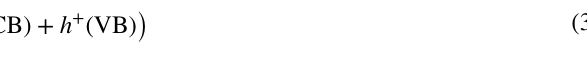
Fig. 12 Possible mechanism for the photoexcited electron–hole separation of the degradation of MB dye by CeO face under